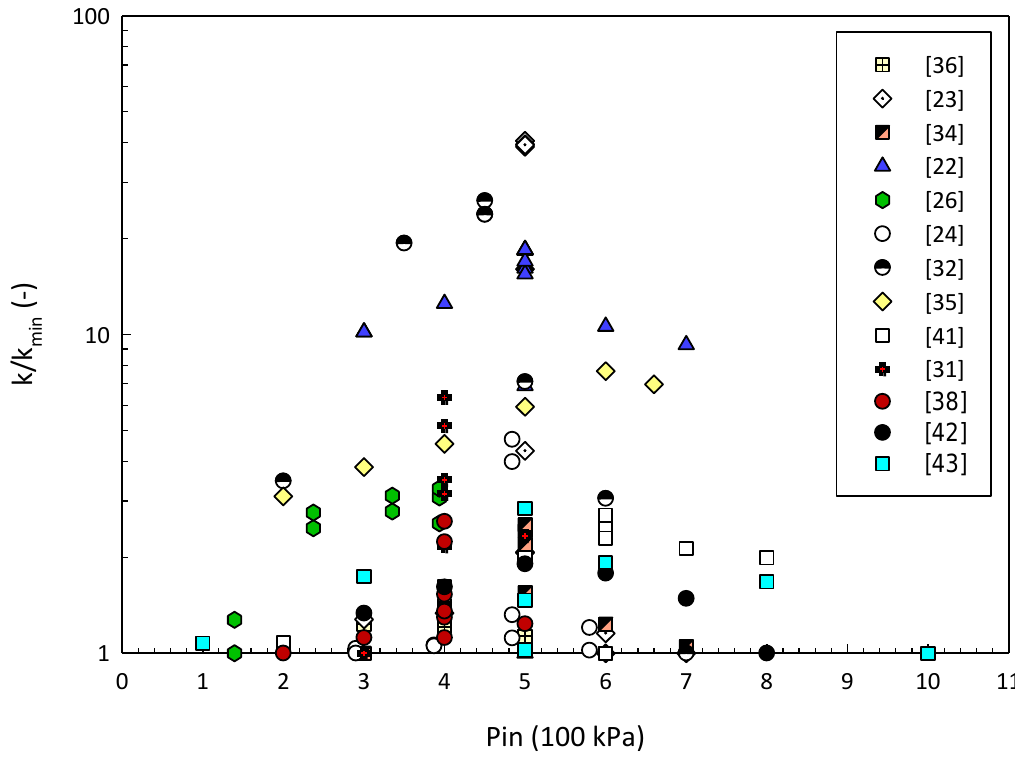
Figure 6. Enhancing factor k/k min vs. inlet pressure from the experimental works of Table 1.